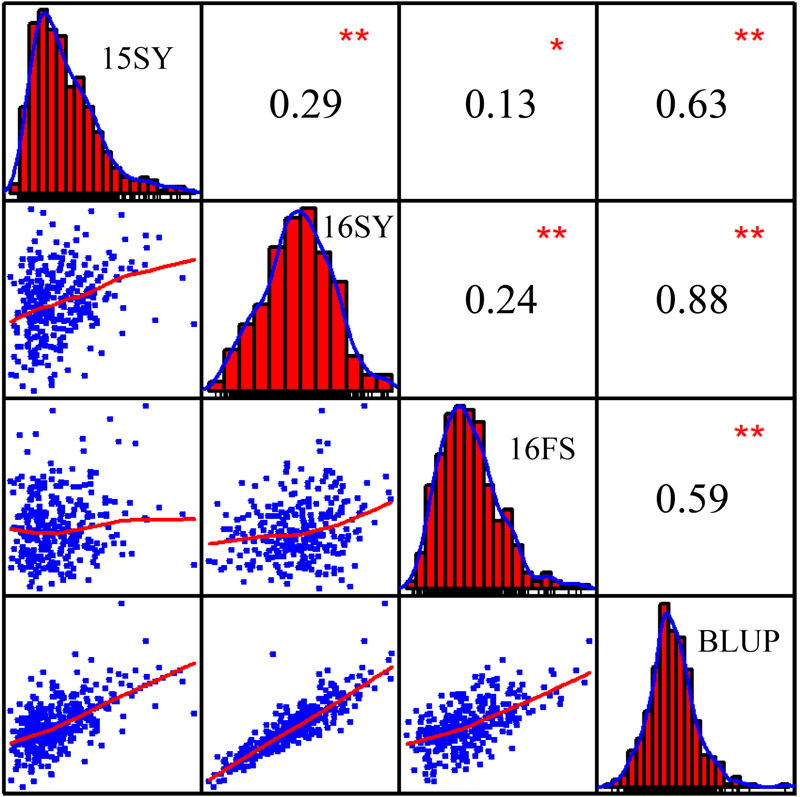
Frequency distributions and correlations for maize husk tightness (HTI) measured in three environments, 15SY (2015 Sanya), 16SY (2016 Sanya), 16FS (2016 Fushun), and BLUP (best unbiased linear predictive value). The plots on the diagonal represent the phenotypic distribution frequency of HTI in 15SY, 16SY, 16FS, and BLUP. The values above the diagonal line are the Pearson’s correlation coefficients between HTIs measured in every two environments. The values below the diagonal line are scatter plots for HTIs measured in every two environments. *Represents a significant difference at the 0.05 level; **Represents a significant difference at the 0.01 level.